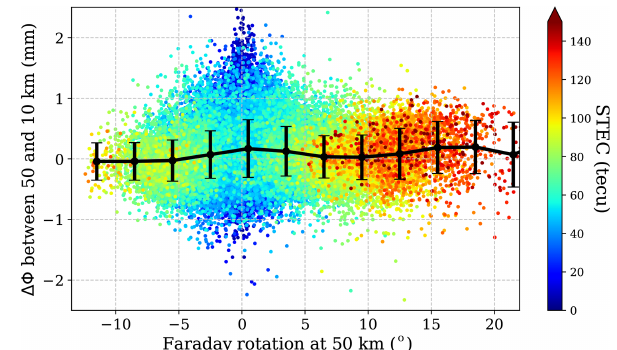
Figure 8. Trend of (cid:49)(cid:56)(h) as a function of Faraday rotation. The (cid:49)(cid:56) is evaluated at the rays with tangent point’s heights of 50 and 10km, and the difference between them is plotted here as a function of (cid:127) evaluated at the ray with tangent point’s height of 50km. The color of the points shows the integrated electron density content along the ray with tangent point’s height of 50km. Solid line is the mean, and the error bars are the standard